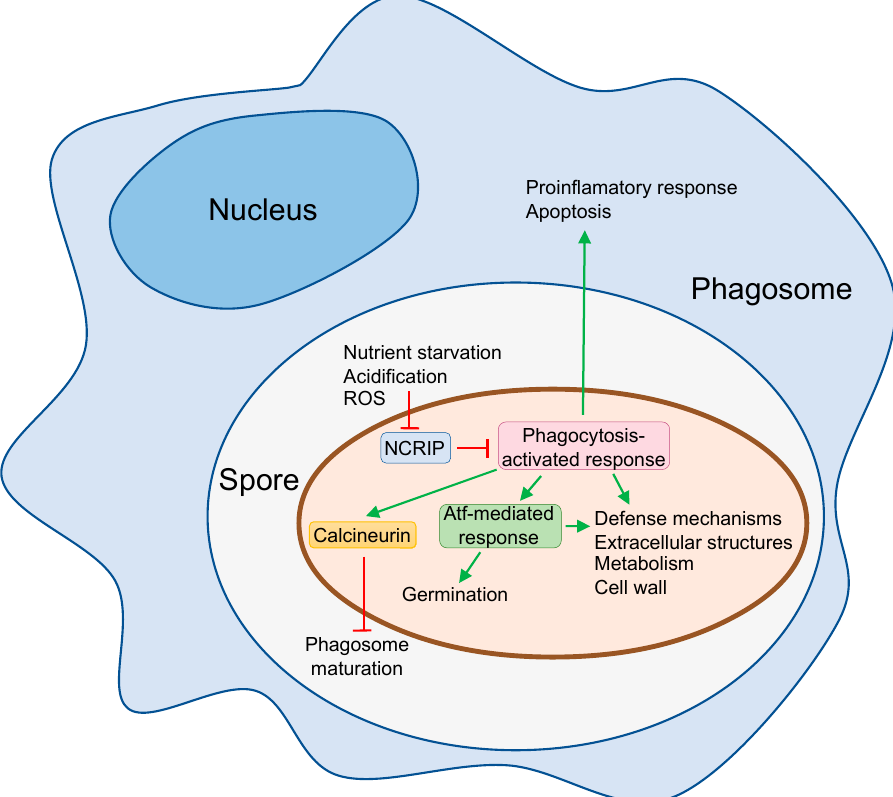
Figure 1. Mechanisms of Mucor circinelloides to escape from macrophage fungistatic activity. When M. circinelloides spores are phagocytized, a complex gene response is activated to survive macrophages attack that encompasses the di ff erential expression of genes involved in defense mechanisms, extracellular structures, metabolism, and cell wall [57]. This response also up-regulates transcription factors atf1 and atf2 that regulate germination at low pH and other processes involved in the response to phagocytosis [57]. Calcineurin pathway is also activated and promotes phagosome maturation arrest [63]. The spore response to phagocytosis also comprises the activation of macrophage genes involved in apoptosis and proinflammatory response [57]. The NCRIP represses most of the genes of the phagocytosis-activated response in the absence of macrophages [58], suggesting that some of the signals present in the phagosome repress this RNAi-related pathway to allow the activation of the spore response to phagocytosis. Green arrow, activation; red T,